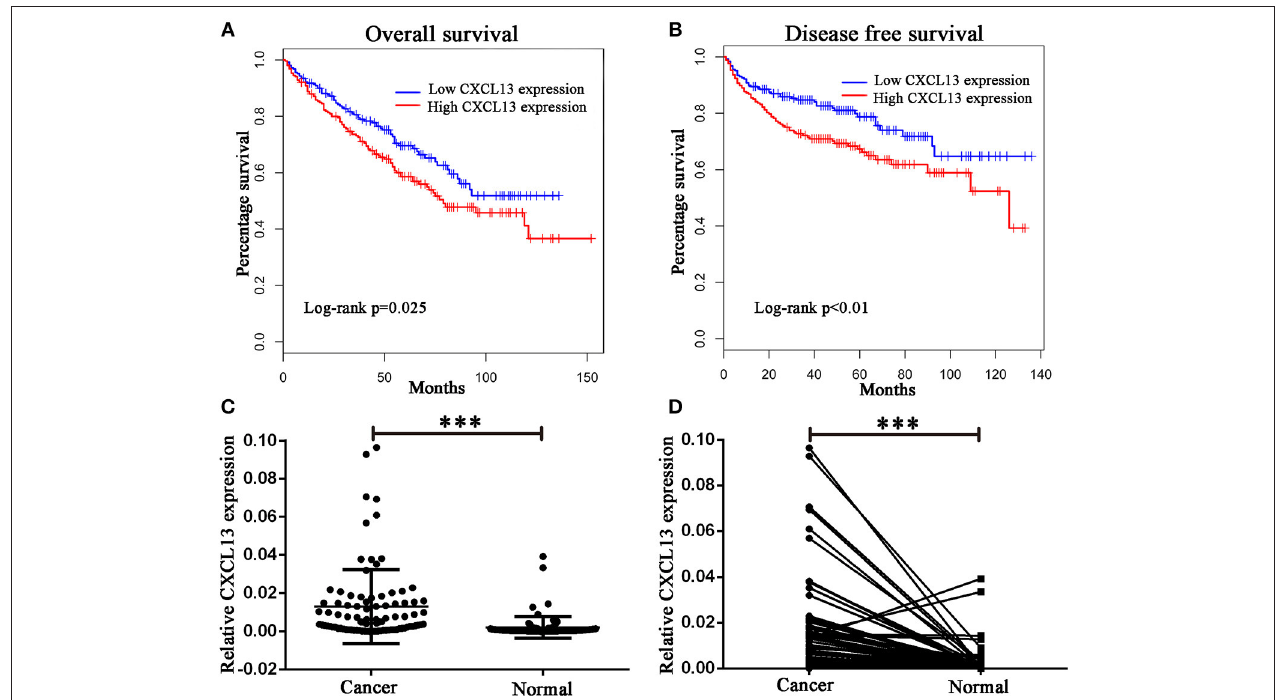
FIGURE 2 | Validation of CXCL13 expression in ccRCC. (A) Kaplan-Meier analysis of overall survival in high-CXCL13-expression and low-CXCL13-expression ccRCC patients (Log-rank test, P = 0.025). (B) Kaplan-Meier analysis of disease free survival in high-CXCL13-expression and low-CXCL13-expression ccRCC patients (Log-rank test, P < 0.01). (C) and (D) Relative CXCL13 mRNA expression in 90 pairs of ccRCC tissues and normal tissues (Student’s t -test, *** P <